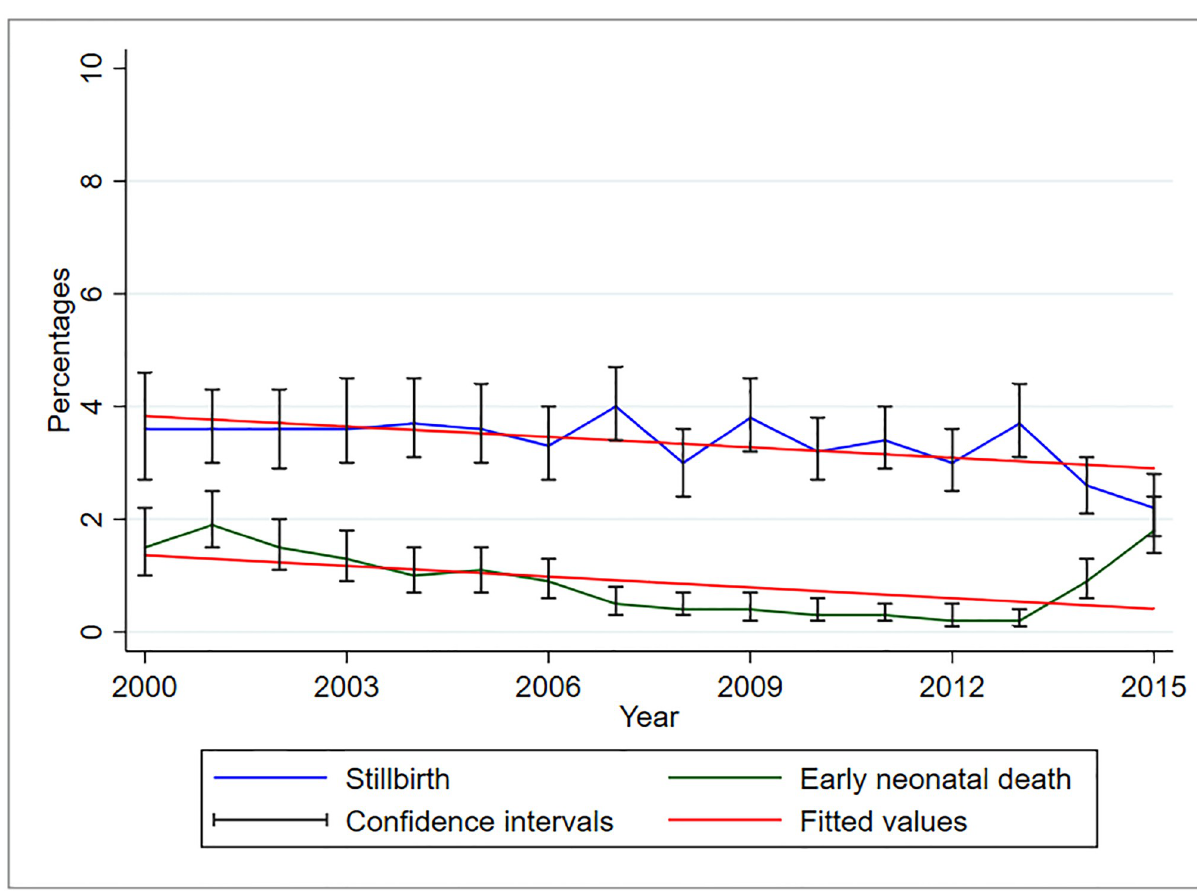
Fig 3. Trends of stillbirths and early neonatal deaths, KCMC medical birth registry data, 2000–2015 (N = 50,724).